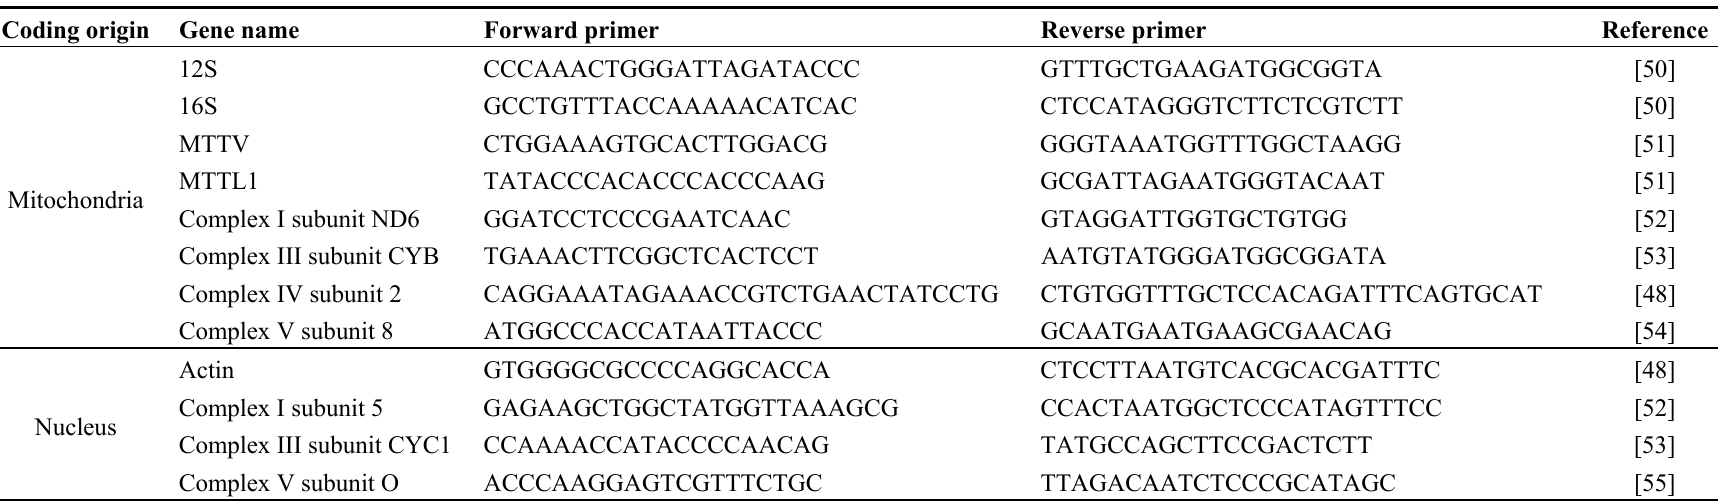
Table 1. PCR primers. The listed primers were used to examine the expression of the following mitochondrial genes—ribosomal RNA: 12S, 16S; transfer RNA; MtTL1 (mitochondrially encoded tRNA leucine 1 (UUA/G)), MtTV (mitochondrially encoded tRNA(Val)); messenger RNA: Complex I subunit ND6; Complex III subunit CYB; Complex IV subunit 2; Complex V subunit 8. The following nuclear genes were also investigated: actin, Complex I subunit 5, Complex III subunit CYC1 and Complex V subunit